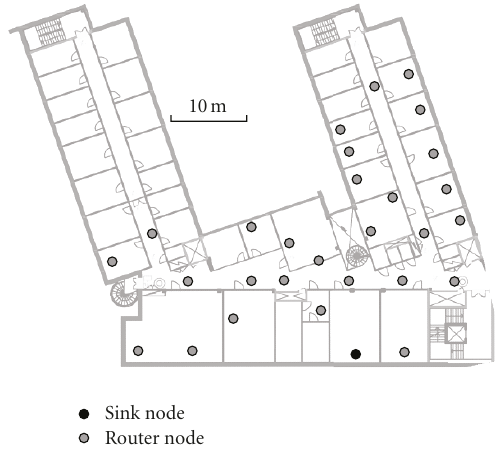
Figure 12: Network deployment at the o ffi ce environment. Net- work included one sink node, while the router node amount varied from 2 to 28.